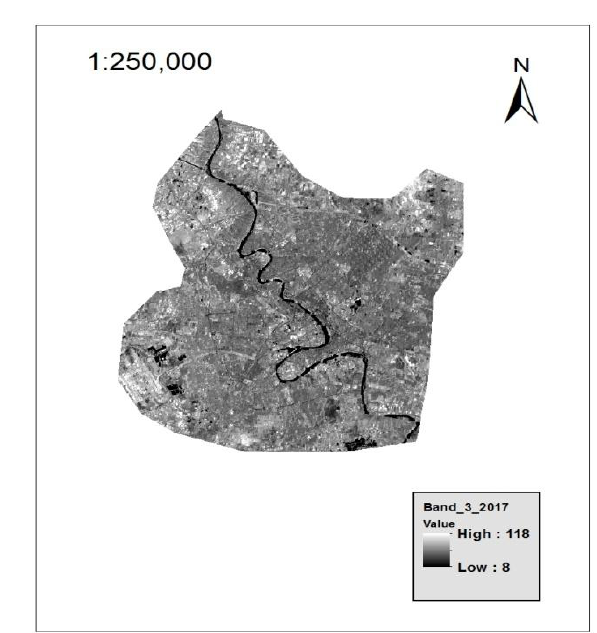
Fig. 12: Show image of band (4) for study area in date